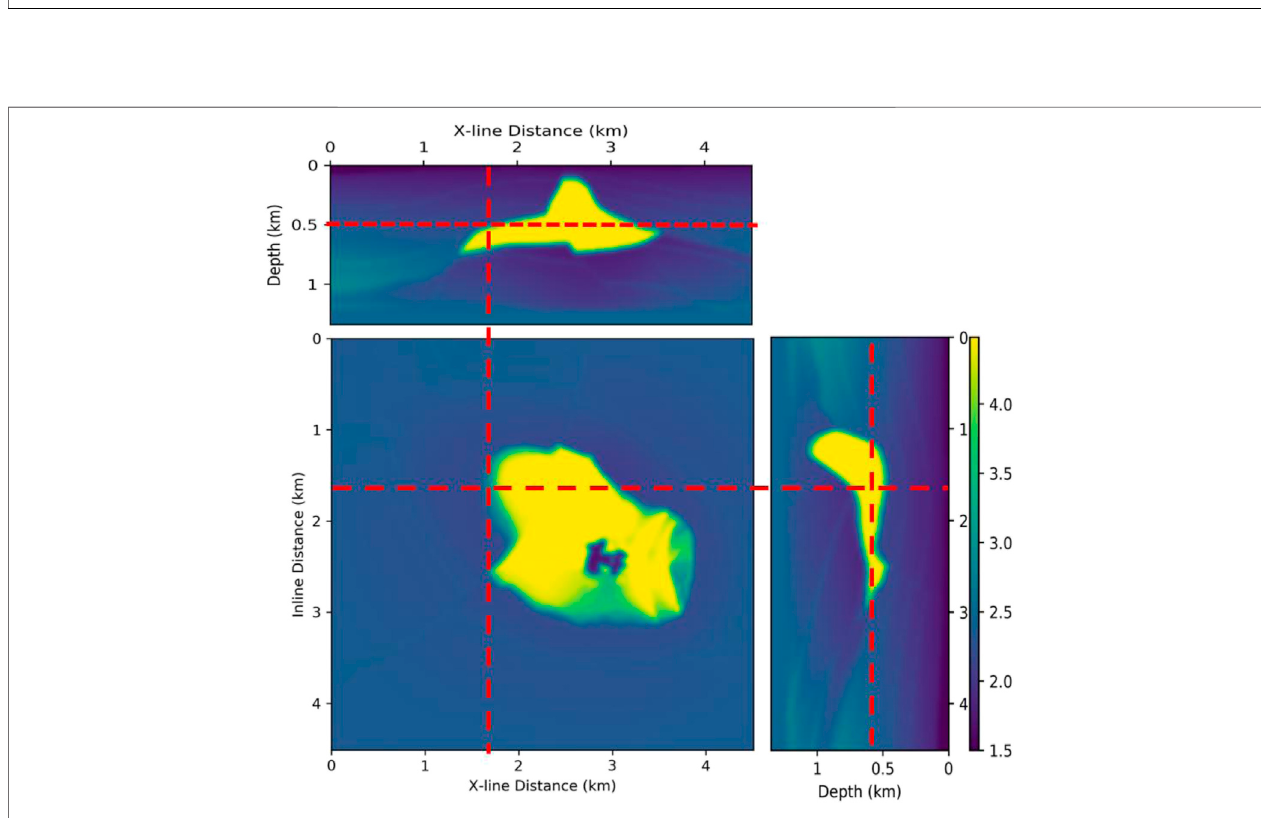
FIGURE 6 | Slices of the P-velocity model of SEG/EAGE 3-D salt model.